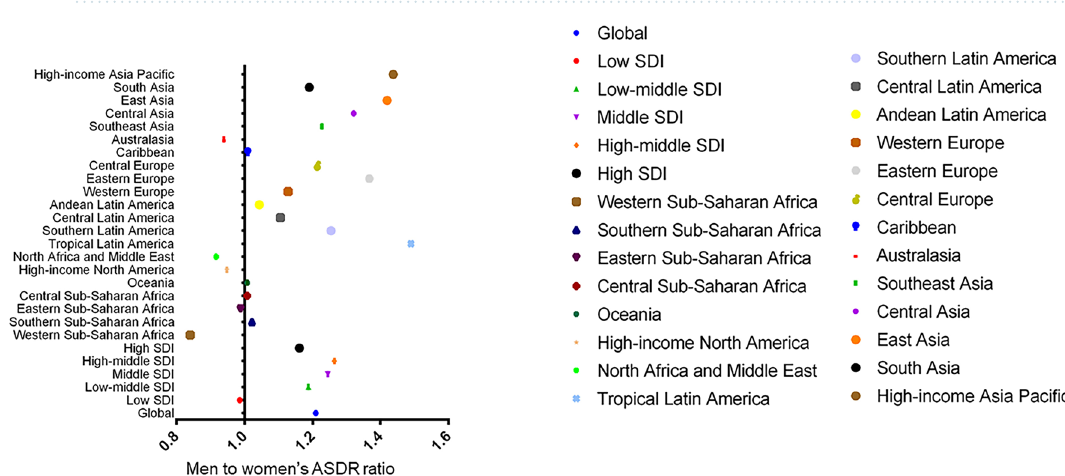
Figure 3. The men to women’s ASDR ratio in global, five SDI regions and 21 geographic regions. Abbreviations: ASDR, age-standardized DALYs rate; SDI, socio-demographic